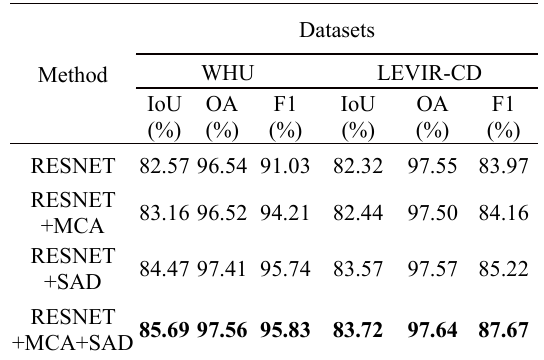
Table 1 . Comparison accuracy on the different datasets in the ablation result of modules. The bold values denote the best result.